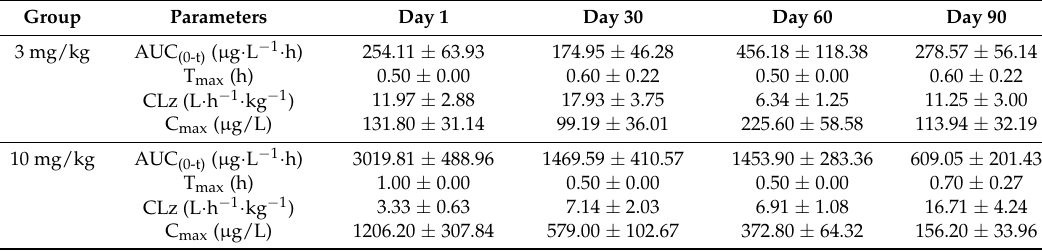
Table 1. Toxicokinetic parameters of FLC (Mean ±